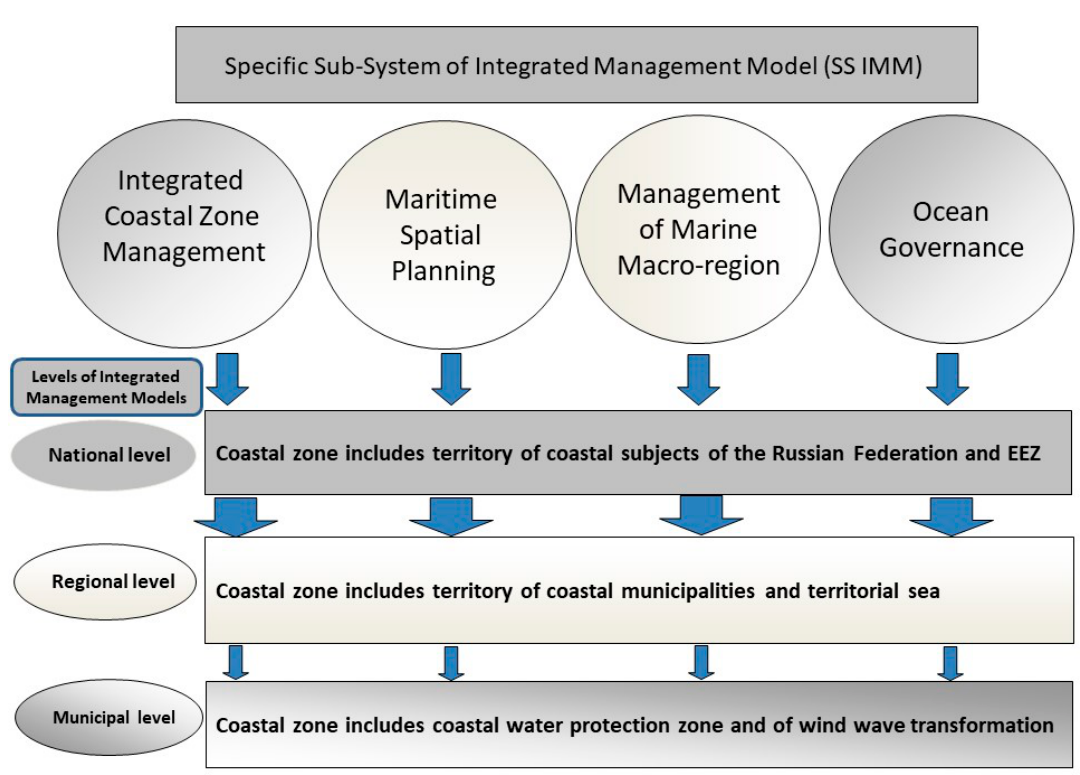
Figure 1. General structure of the proposed Integrated Management Model for sustainable sea and coastal use in the Russian Federation.